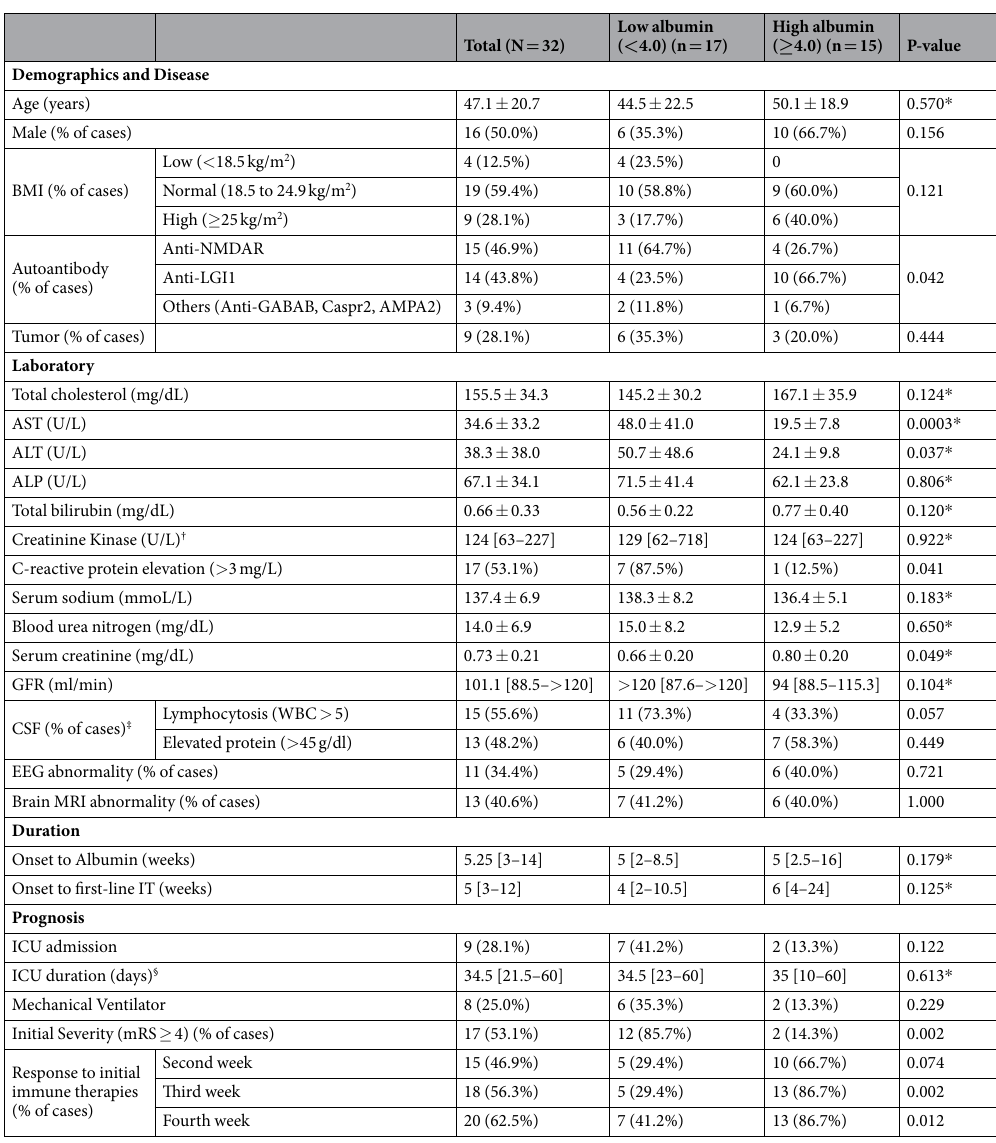
Table 1. Factors associated with low albumin level. BMI = body mass index; NMDAR =